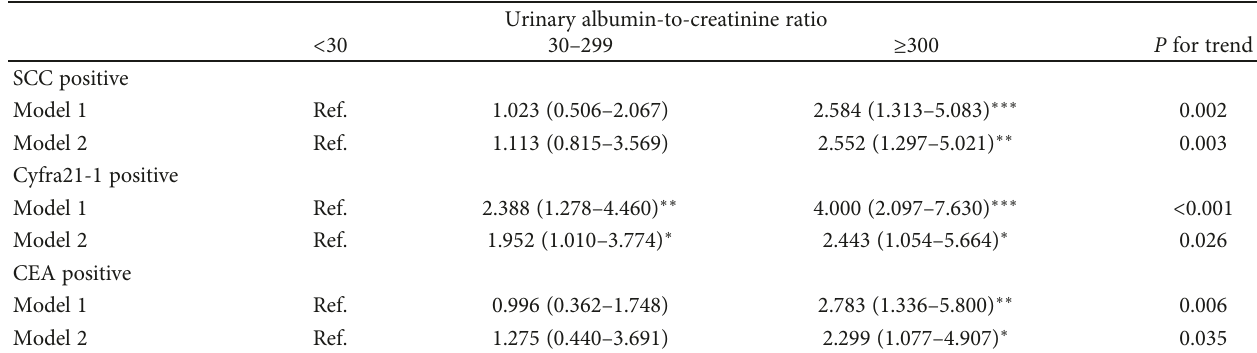
Table 4: Associations of urinary albumin-to-creatinine ratio with tumor marker status (positive or negative) in diabetic